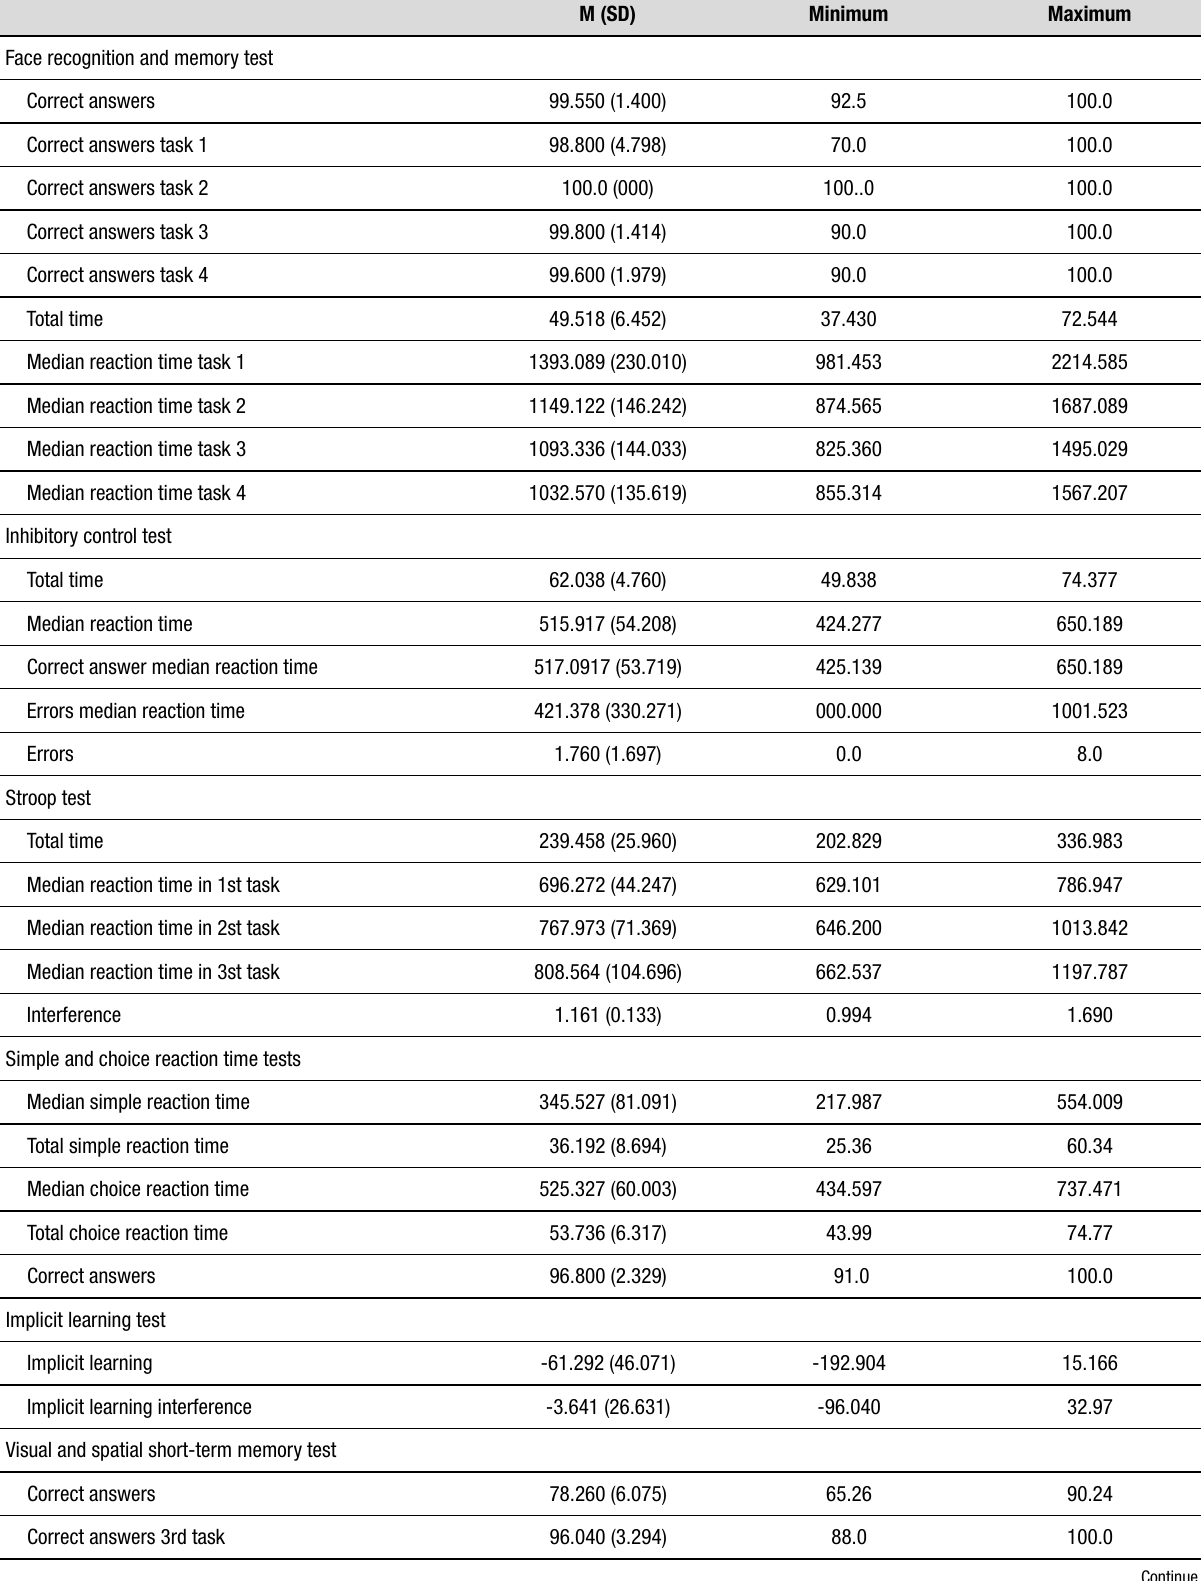
Table 5. Participants’ performance in each